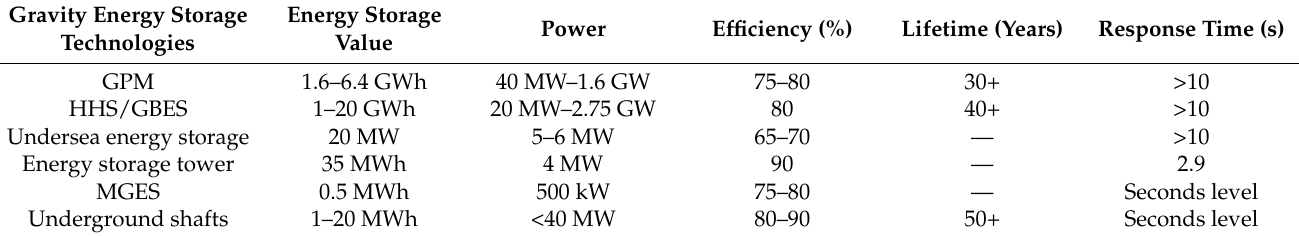
Table 2. Comparison of various gravity energy storage technologies